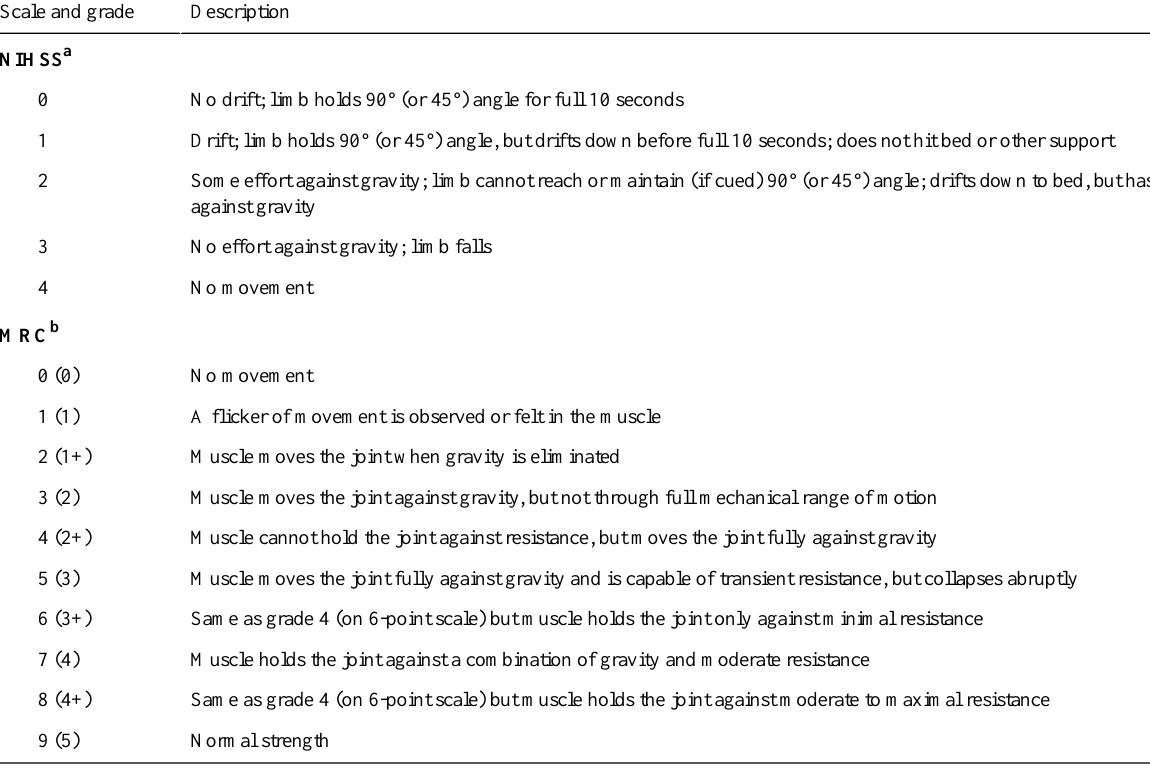
Table 1. NIHSS and MRC grades for muscle power